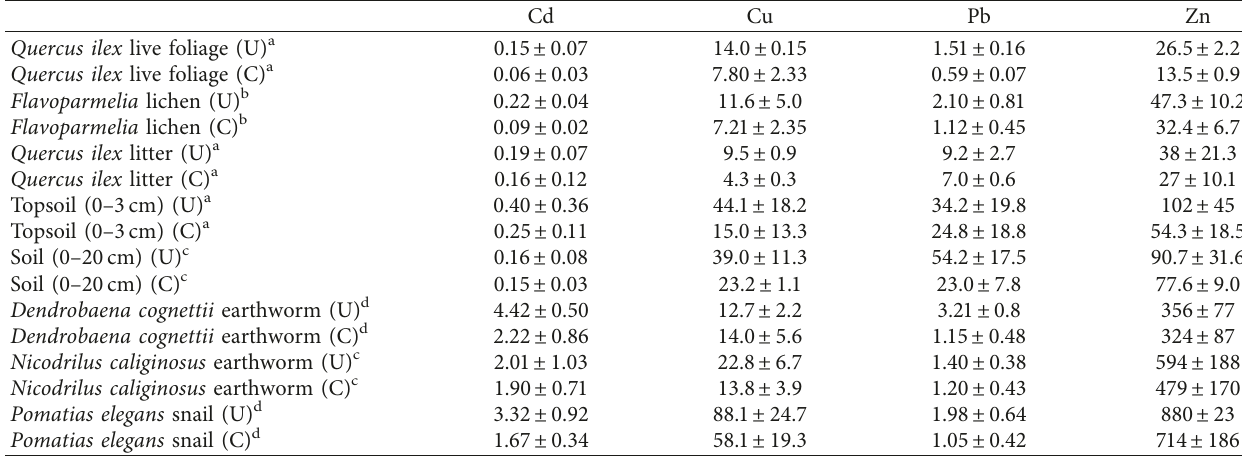
Table 1: Mean Cd, Cu, Pb, and Zn concentrations ( µ g · g − 1 ± SD) in biotic and abiotic matrices from Siena urban green areas (U) and extraurban control sites (C).